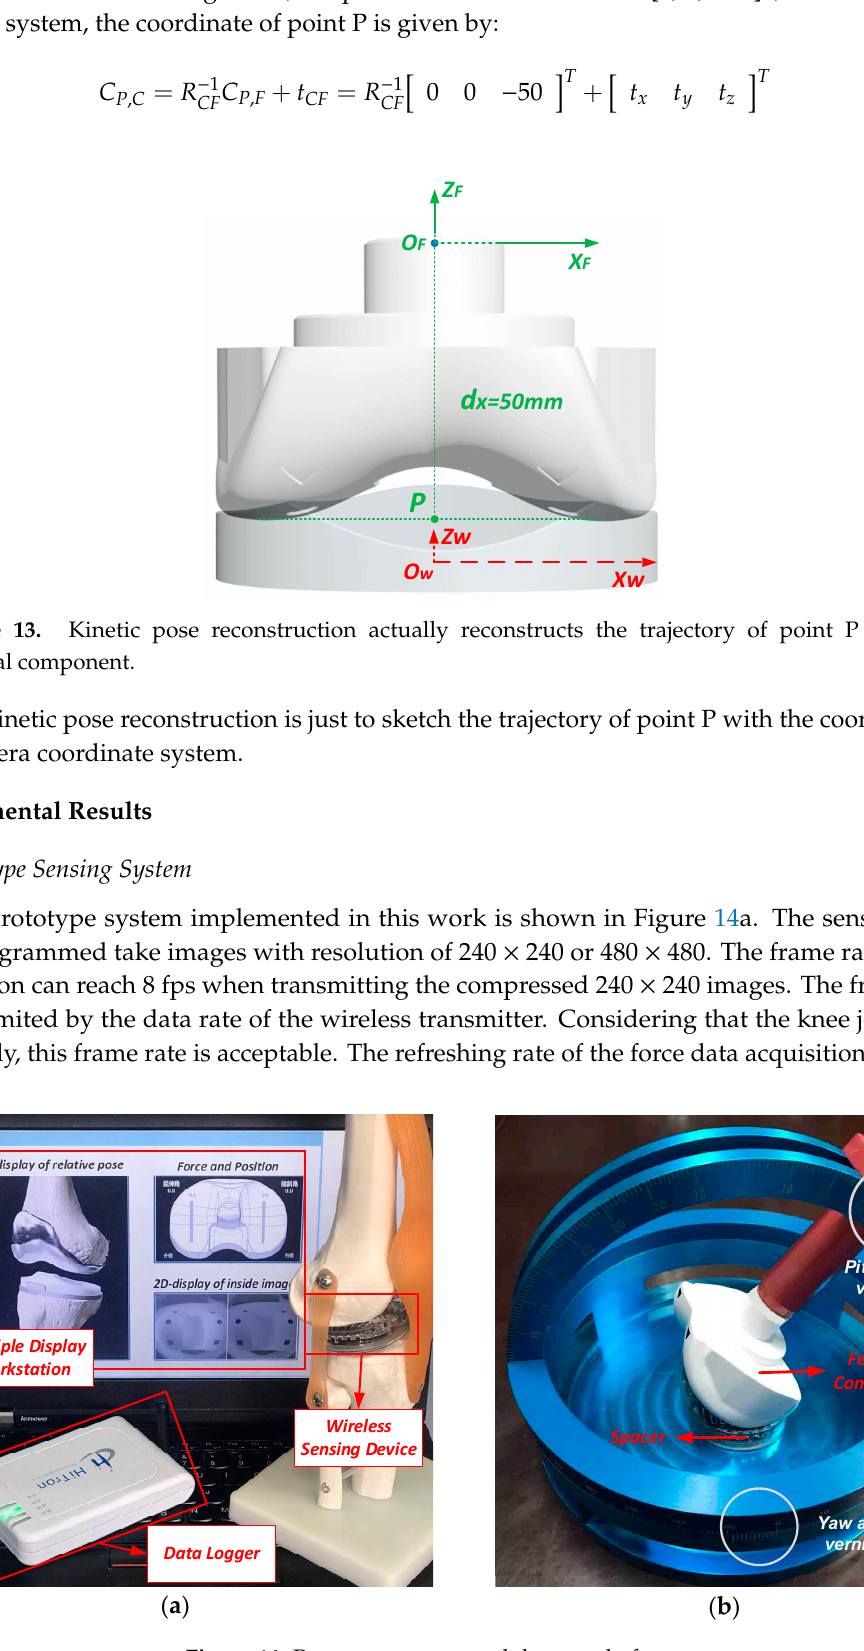
(d) Figure 15. Instant relative pose reconstruction: ( a ) original image, ( b ) after denoising and contrast enhancement, ( c ) after lens distortion correction, ( d ) control point recognition, ( e ) instant pose reconstruction.